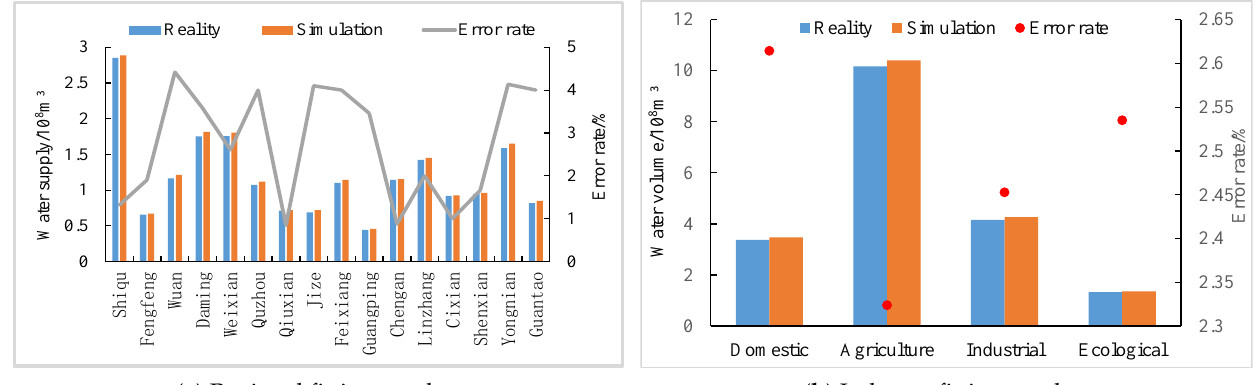
Figure 7. Verification of simulation results.